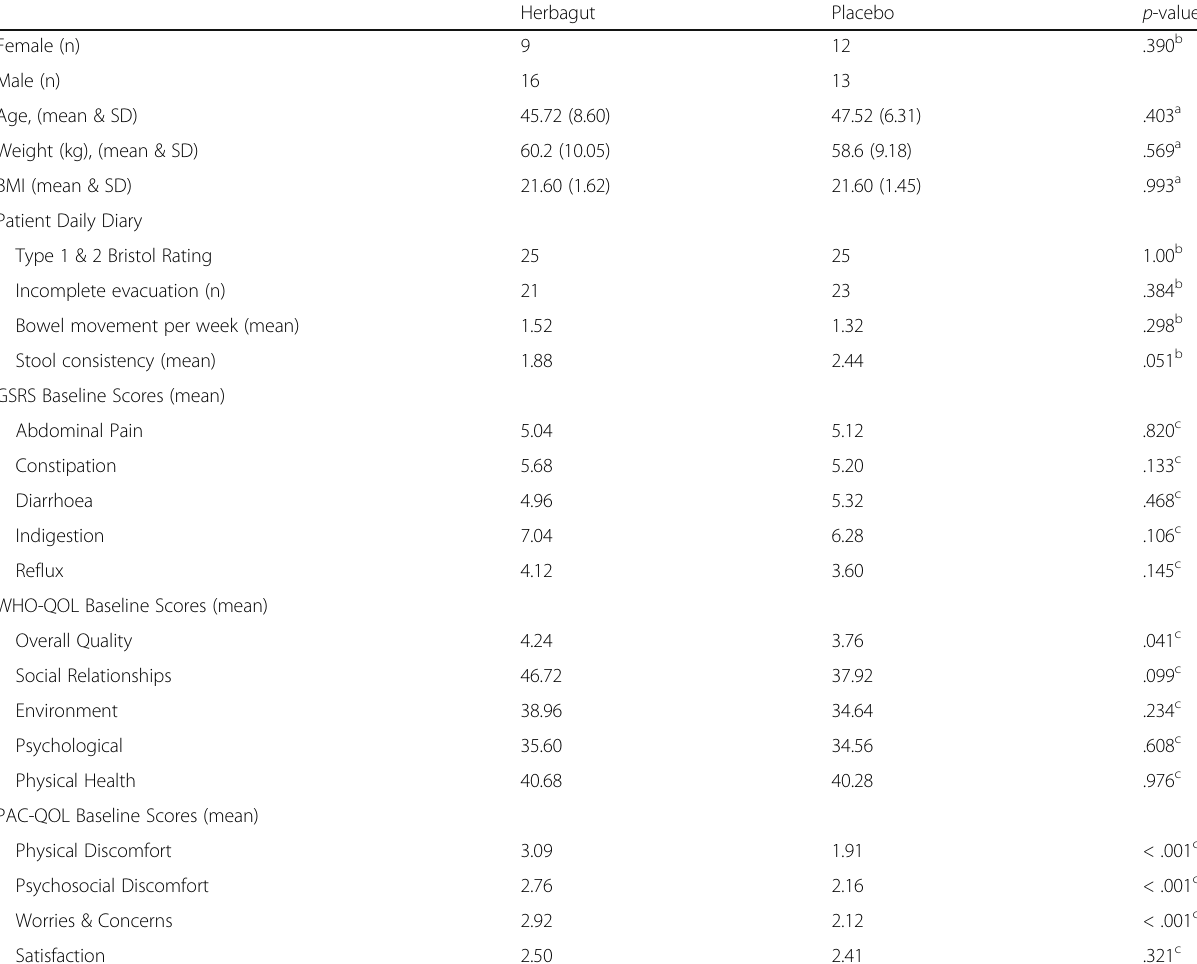
Table 1 Participant baseline demographic characteristics